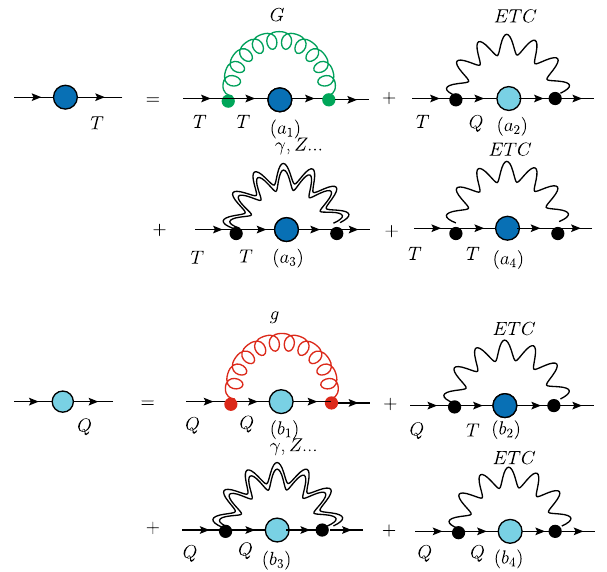
Fig. 1 The coupled system of SDEs for TC ( T ≡ technifermion) and QCD ( Q ≡ quark). This system may also include ETC and electroweak or any other corrections, and some of these are indicated in the figure. G ( g ) indicates a technigluon